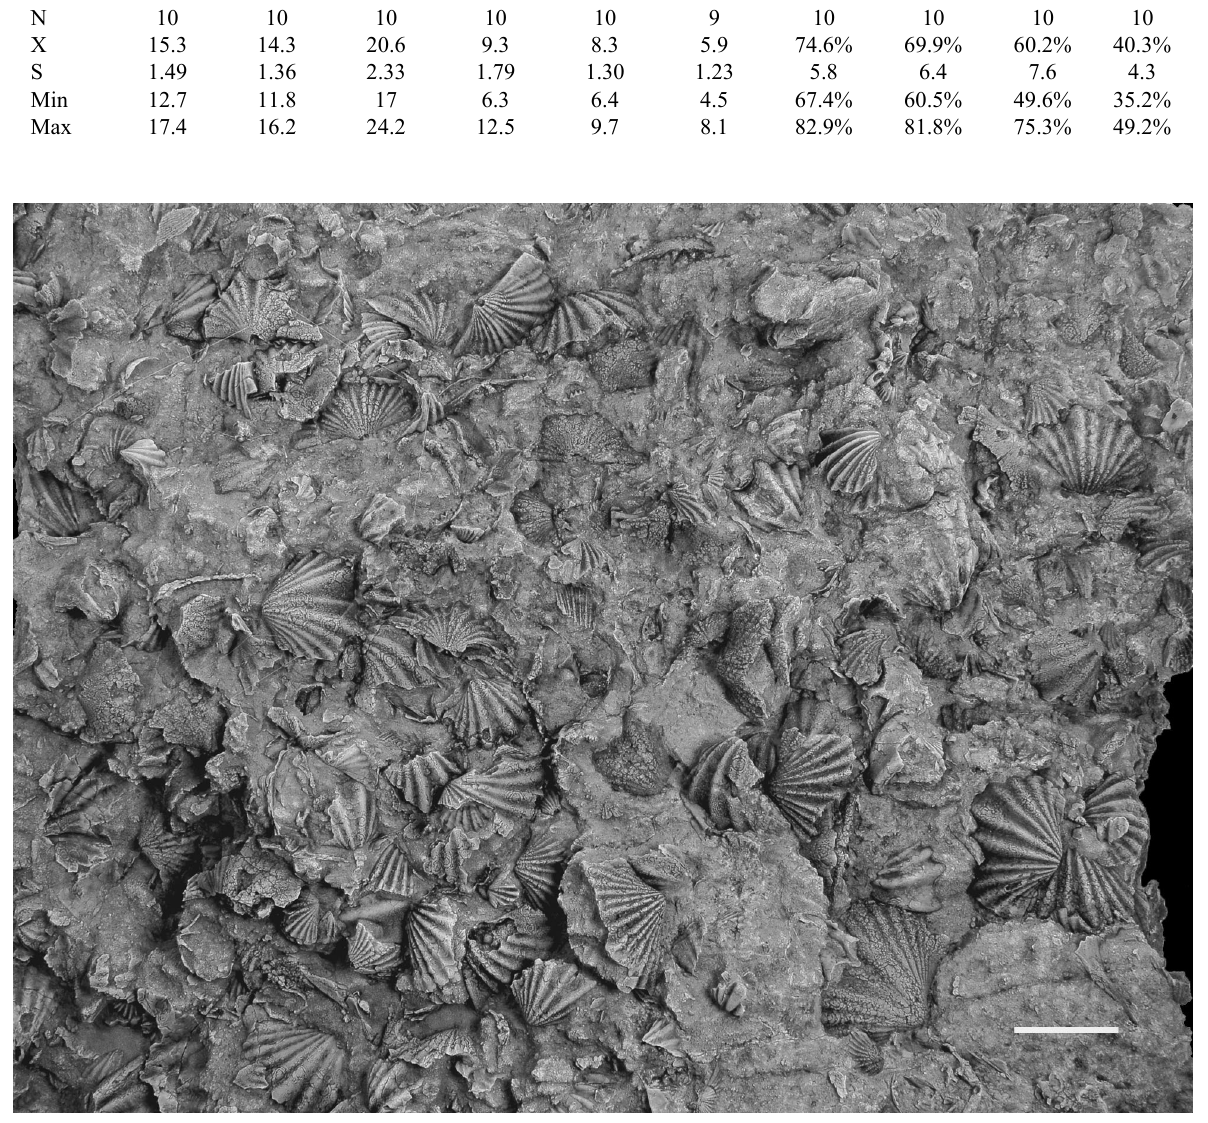
Fig. 9. Surface of a shell bed showing accumulation of Stegocornu denisae sp. nov.; Llandovery, mid-late Aeronian, Niur Formation, sample S12, Derenjal Mountains; scale bar 10